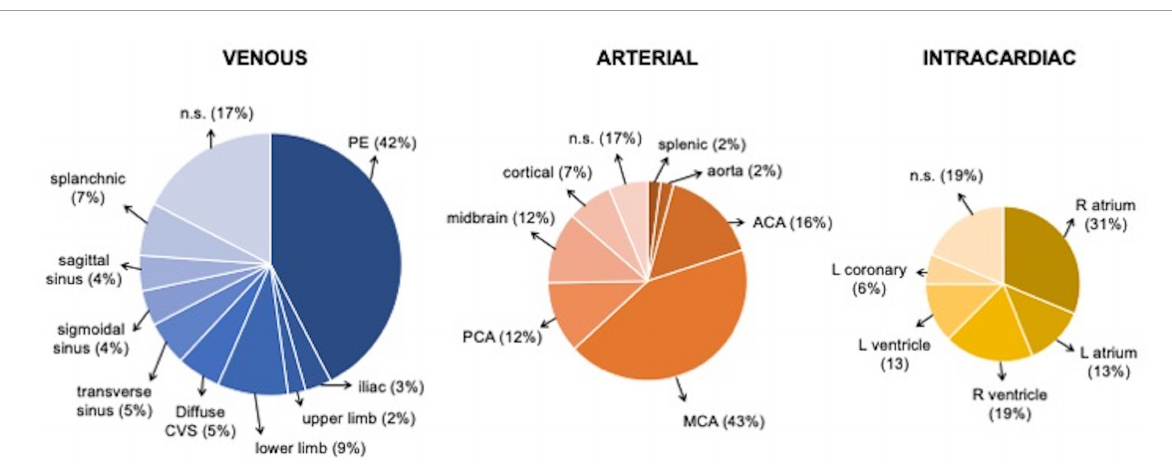
abdominal (18), and thoracic tract (19), respectively, and 1 with coronary thrombosis (20) ( Supplementary Table 1